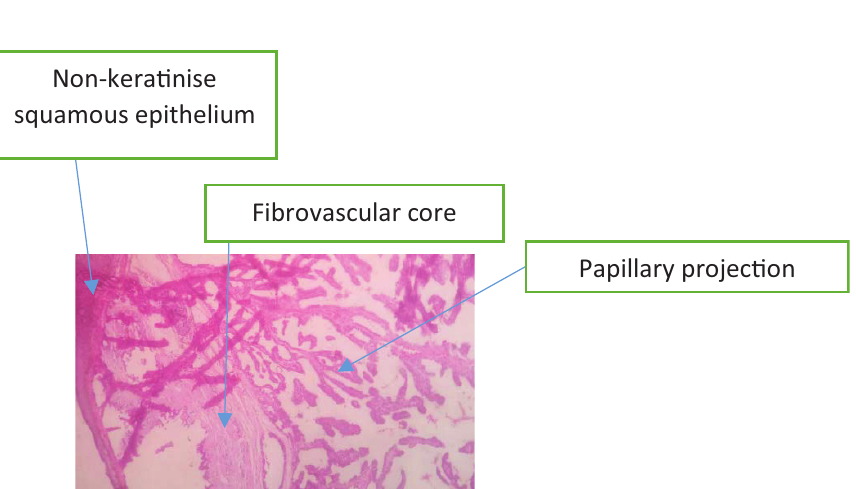
Figure 1: Microscopy section shows projected papillary, plasmacytic infiltrates and non-keratinised